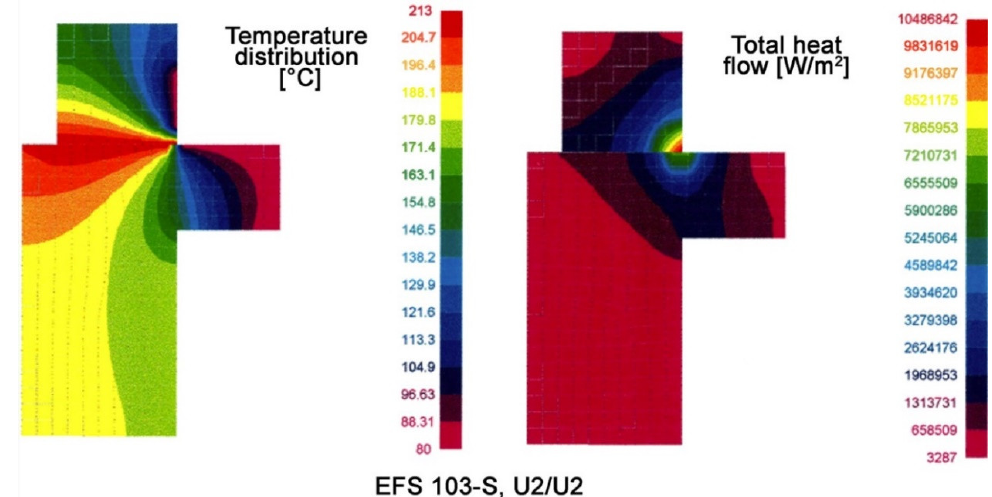
Figure 9. Temperature distribution and total heat flow for MFS, EFS 103−S, U2/U2.